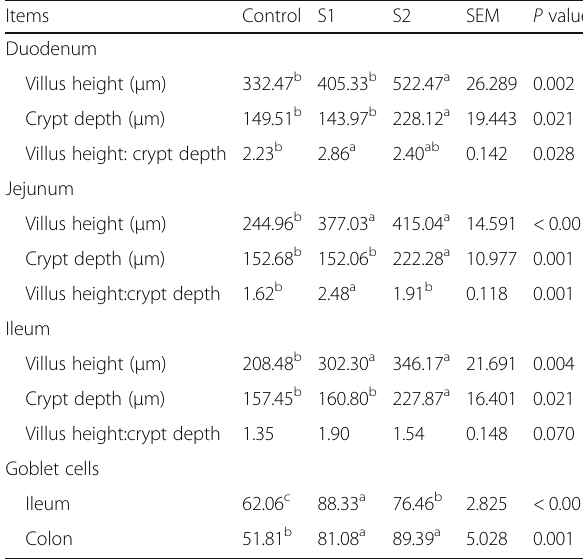
Table 3 Effect of gastric infusion of SCFA on intestinal morphology and number of goblet cell in weaned piglets